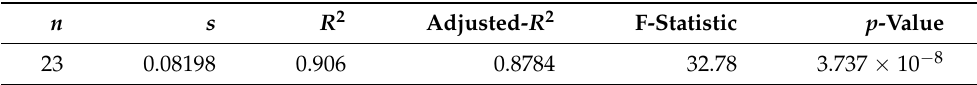
Table 9. Nuclear power plant model